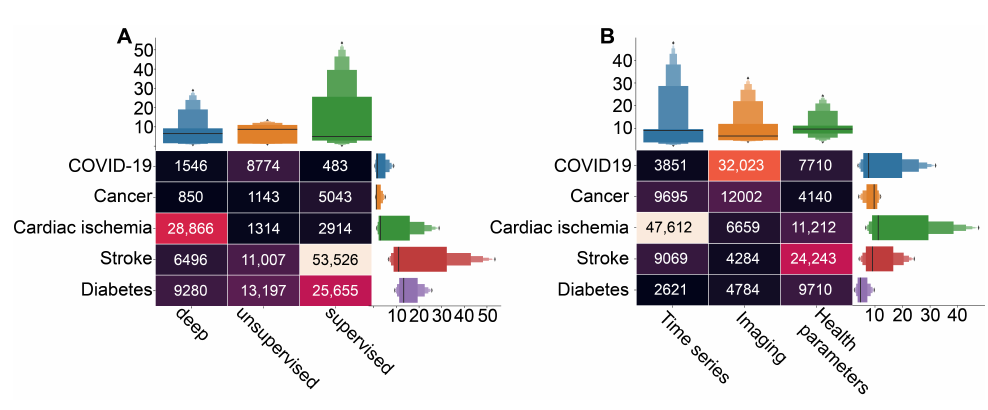
Figure 6. The results of the queries with the number of the acquired papers on particular diseases research in combination with different data ( A ) and machine learning types ( B